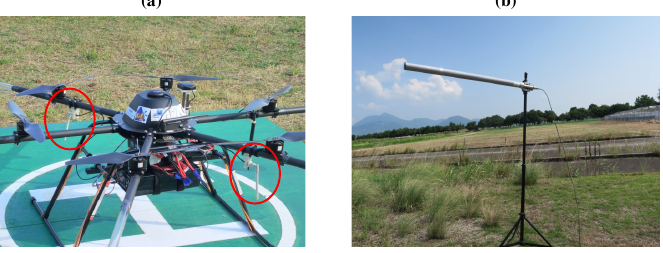
Figure 4. ( a ) antennas on the UAV marked as red circles; ( b ) the Yagi antenna at a ground